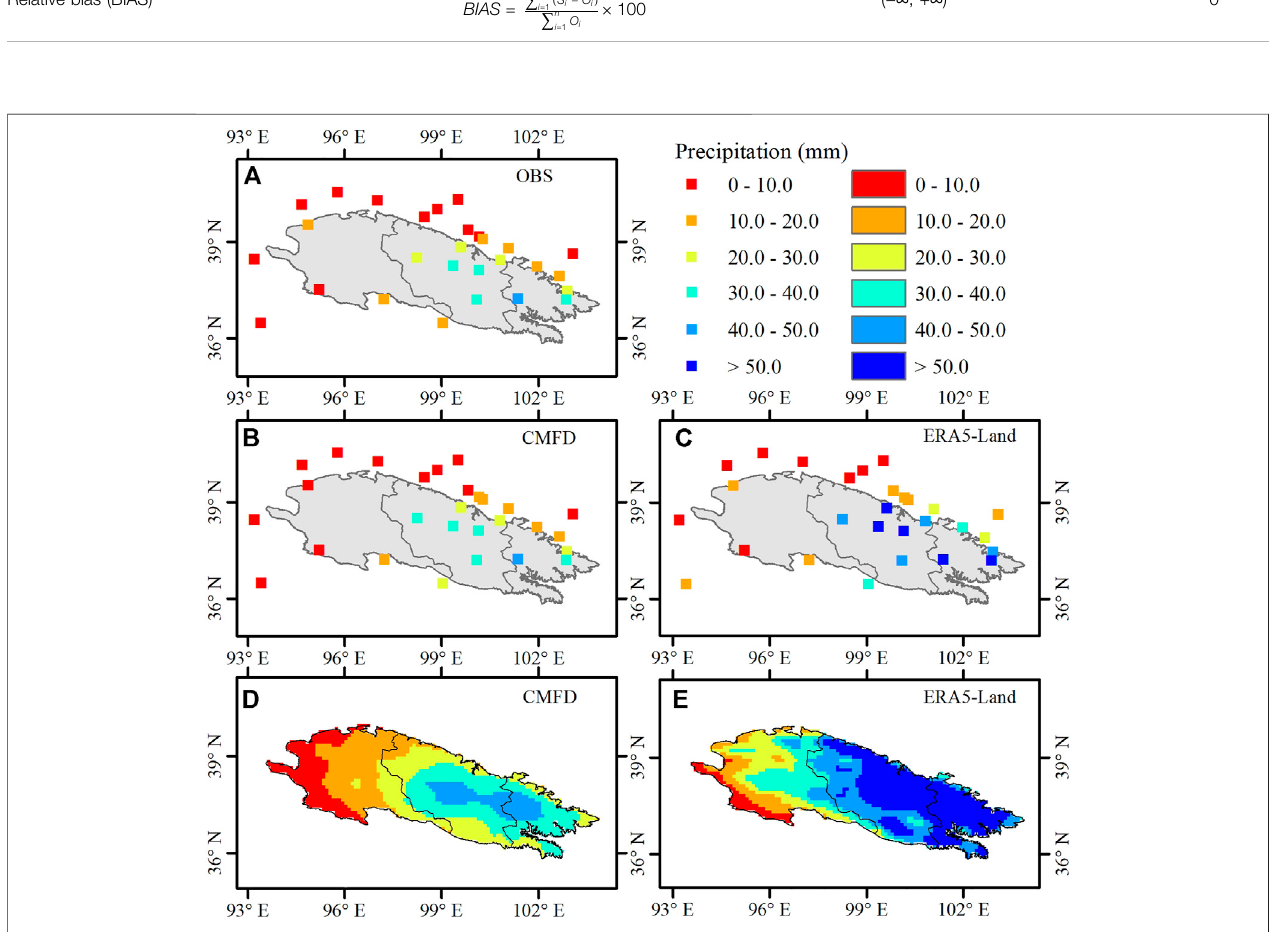
FIGURE 2| (A – C) Spatial distribution ofmean monthly precipitation in the Qilian Mountainsfor the period 1980 – 2018, from station observations (OBS), CMFD (D) and ERA5-Land (E) .